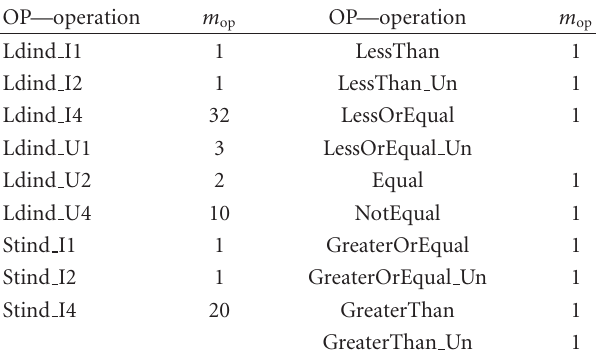
Table 2: Application requirement for load and store and compari- son operations for Mp3.